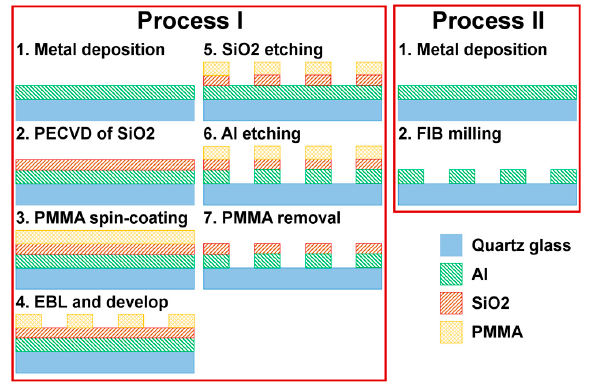
Figure 5. Fabrication process flows for the nanoaperture-based PMMs (process I) and the nanoslit-based PMMs (process II). PECVD = plasma-enhanced chemical vapor deposition; PMMA = poly-methyl methacrylate; EBL = electron beam lithography; FIB = focused ion beam.